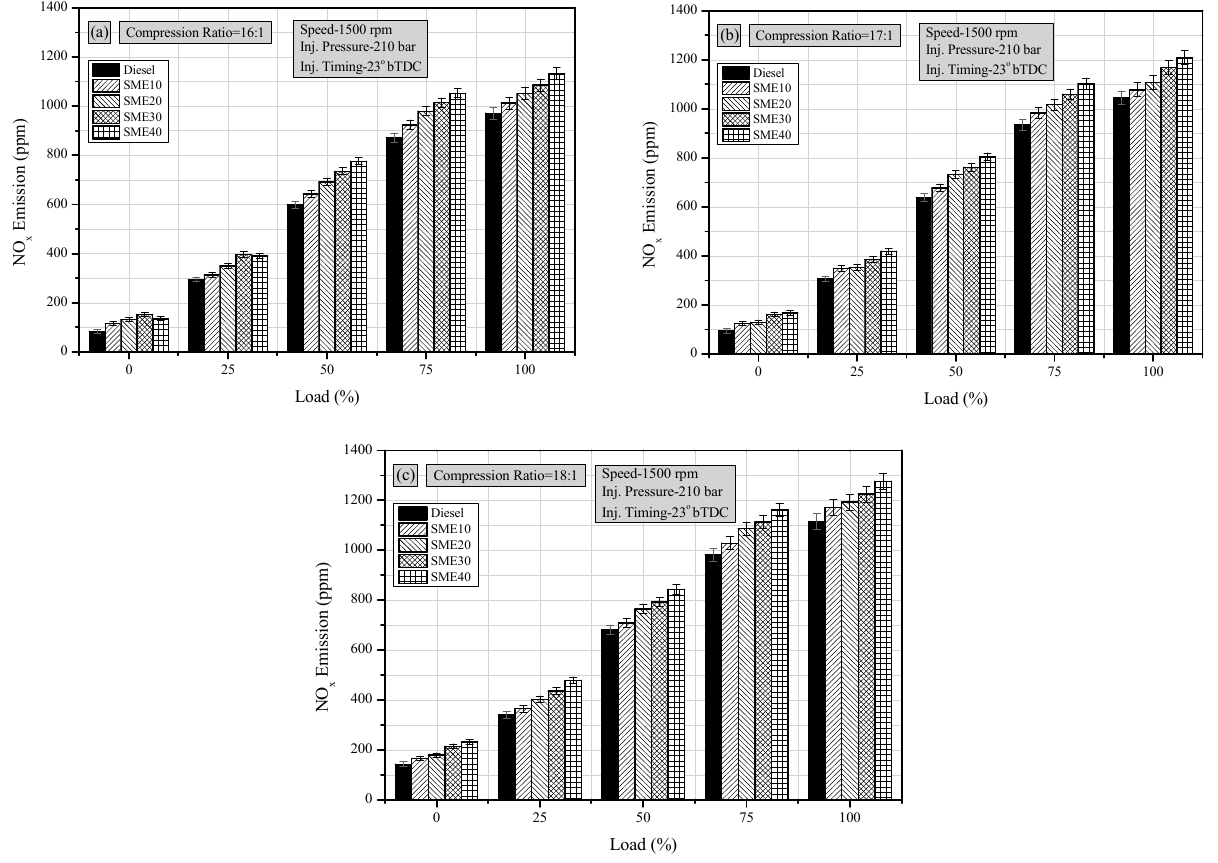
Figure 9. Variation of NO x with load for the fuel blends at CRs: ( a ) 16:1 ( b ) 17:1 ( c ) 18:1. Smoke emissions make up the majority of the solid particles released by IC engines.